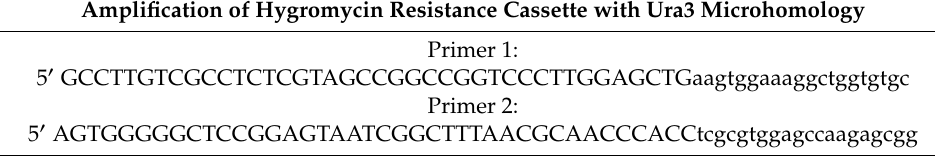
Table 1. Oligonucleotides and crRNA’s used for this